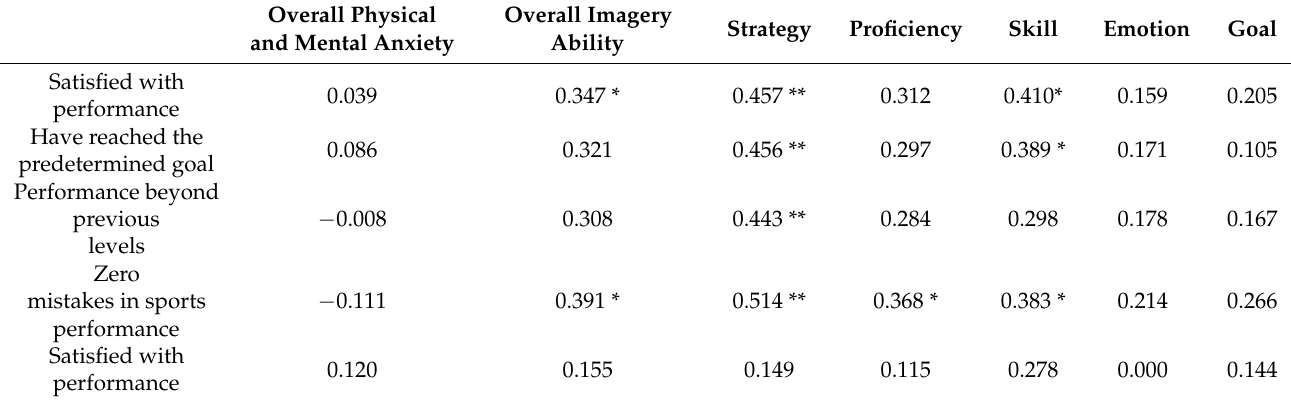
Table 7. Analysis of the correlation between imaginative ability and physical anxiety on sports